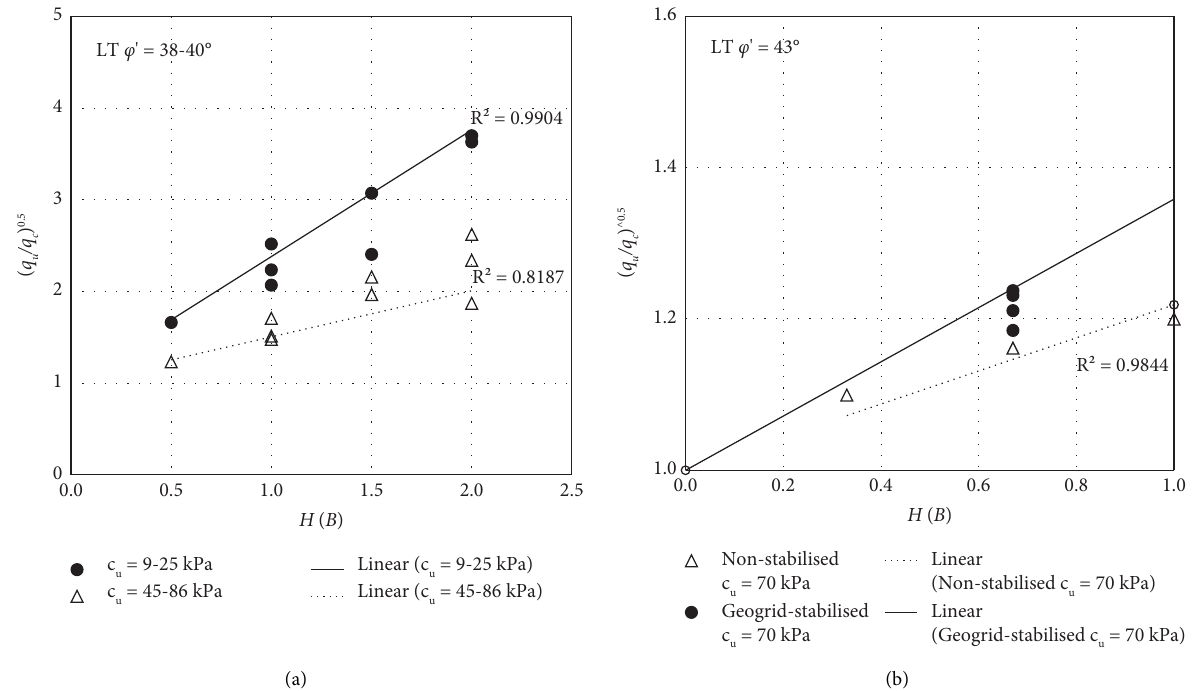
Figure 4: ( q q ) 0 . 5 versus H/B for an unstabilised granular layer (data source: (a) Okamura et al. [7] and (b) Laman et al. [32]): (a) LT u / c ϕ ′ � 38–40 ° and (b) LT ϕ ′ � 43 ° .